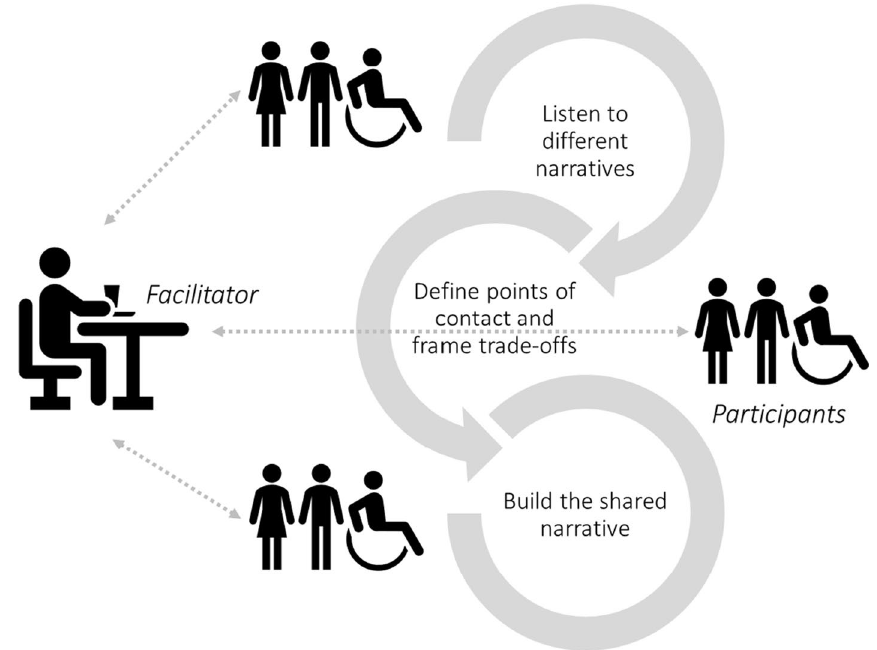
Fig. 2 Illustration of the narra- tive building